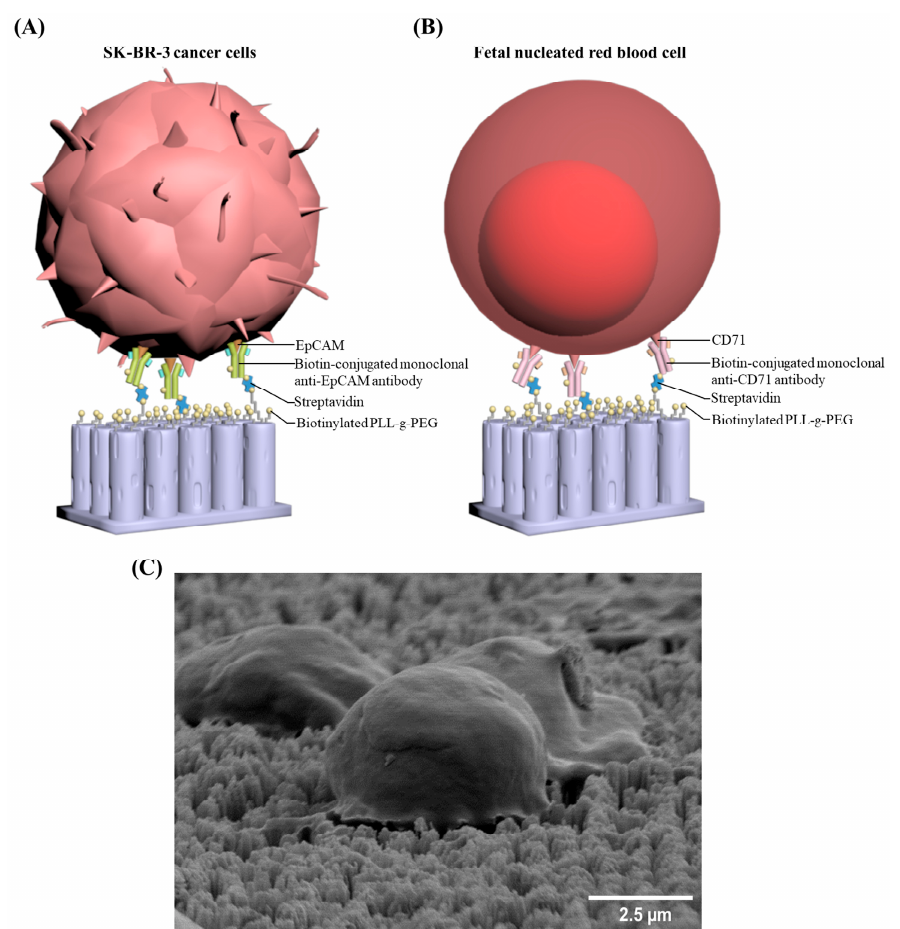
Figure 2. Rare cell captures by the Coral Chip: The Coral Chip surface is coated with biotinylated PLL-g-PEG + streptavidin, and the potential targeted cells are pre-labeled with biotinylated antibodies. The strong interaction between streptavidin and biotin enhances the capturing effect. ( A ) A schematic diagram of the SK-BR-3 cancer cells captured from an artificial cell mixture with a large amount of Jurkat cells as the background. ( B ) A schematic diagram of the fetal nucleated red blood cells (fnRBCs) captured from the peripheral blood of pregnant women. ( C ) Scanning electron microscope (SEM) micrographs of the targeted cells captured on Coral Chip.